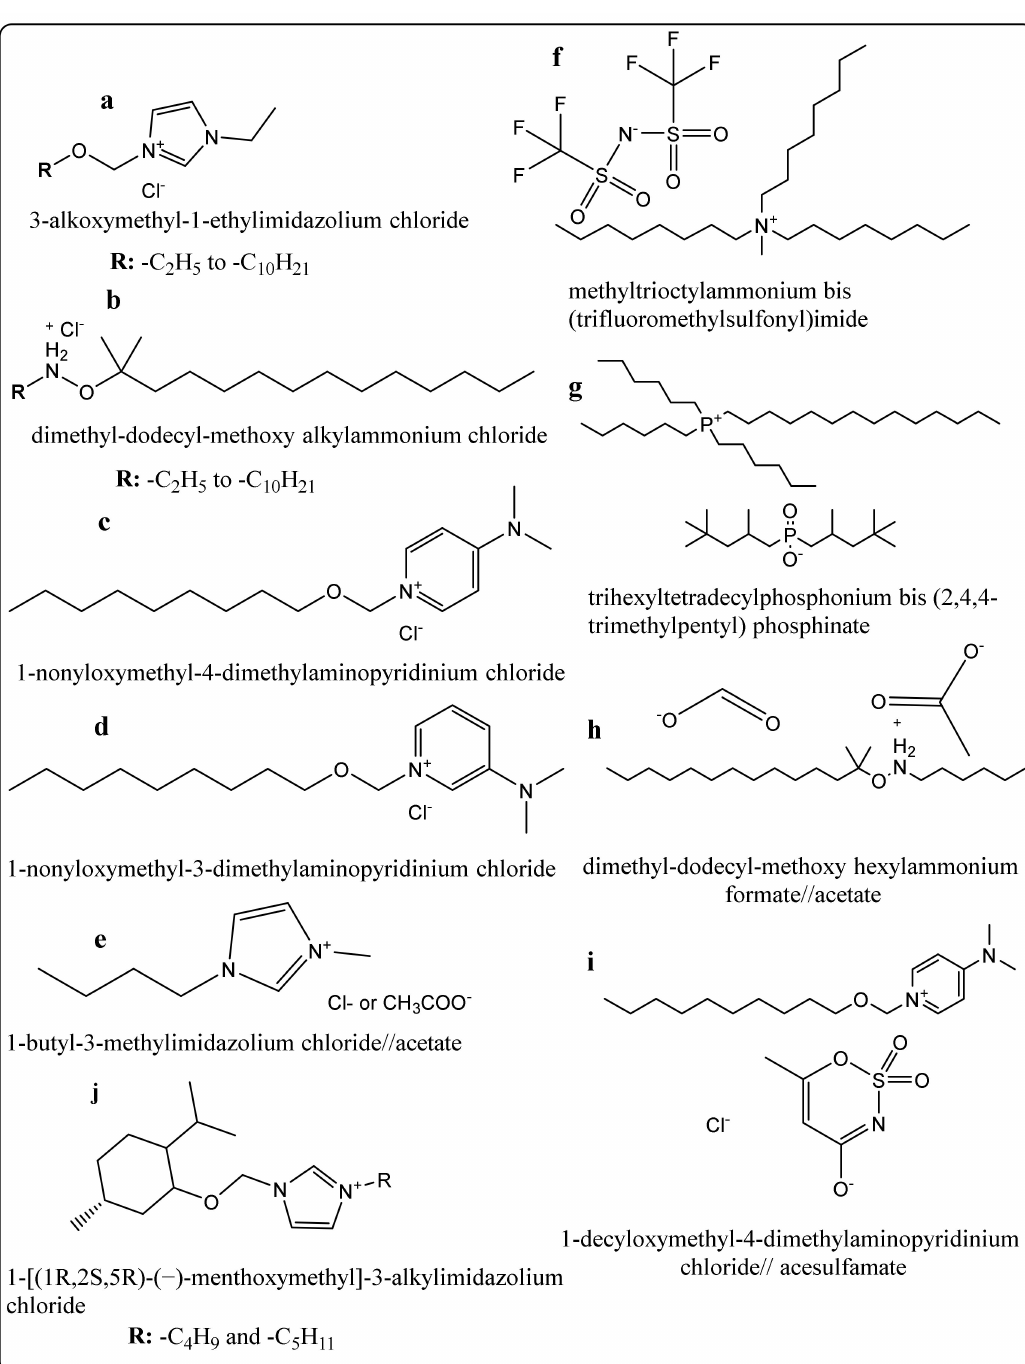
Figure 5. Chemical structures of the ionic liquids with antifungal